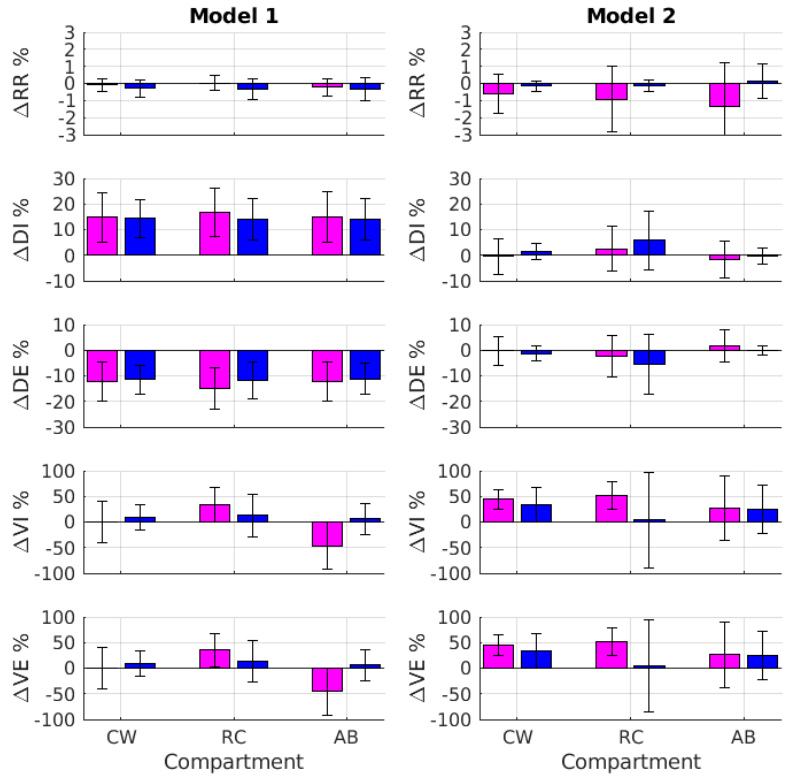
Figure 7. From top to bottom, the panels show the error percentage (mean and one standard deviation error bar) concerning all assessed respiratory variables (i.e., RR, DI, DE, VI, and VE) related to IMU-based Model 1 (on the left ) and Model 2 (on the right ) for both female and male groups (pink and blue, respectively). Table 6. Outcomes of three-way ANOVA for the analysis of gender (2 levels: female and male), compartment (3 levels: CW, RC, and AB), and model (2 levels: Model 1 and Model 2 ) on the relative error percentage of respiratory parameters assessed with IMU-based models (data reported in Figure 7). The p -values are highlighted in bold when reaching significance ( p < 0.05). p -Values/Factor Gender Compartment Model ∆ RR% 0.209 0.808 0.179 ∆ DI% 0.881 0.026 <0.001 ∆ DE% 0.939 0.008 <0.001 ∆ VI% 0.470 0.267 <0.001 ∆ VE% 0.487 0.280 <0.001